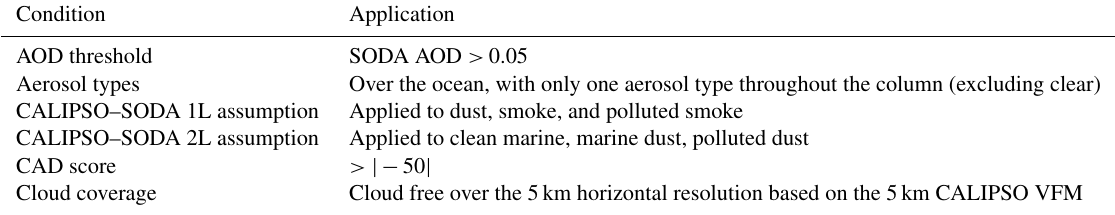
Table 2. Summary of methodology applied to CALIPSO–SODA and V4 intercomparison.